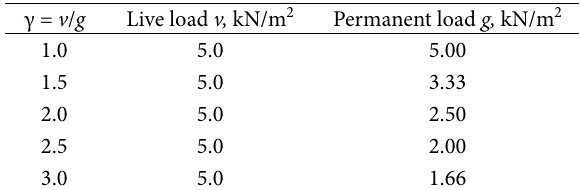
Table 2 . Loading characteristics